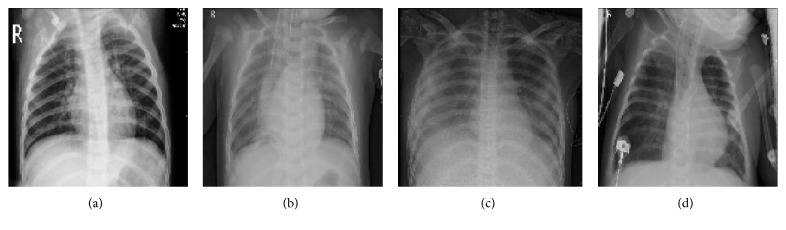
Sample images with pneumonia [10].